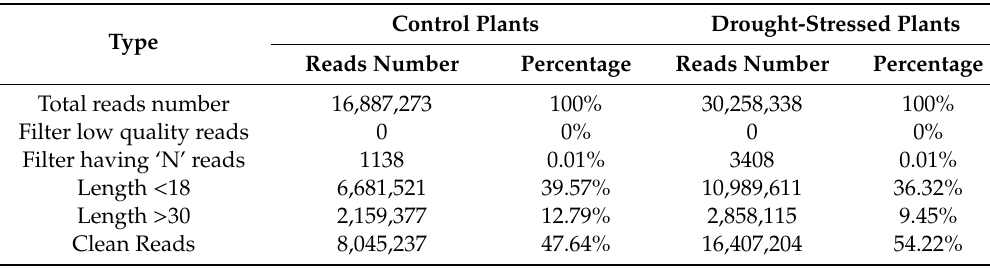
Table 3. Analysis of deep sequencing data of miRNAs in A.